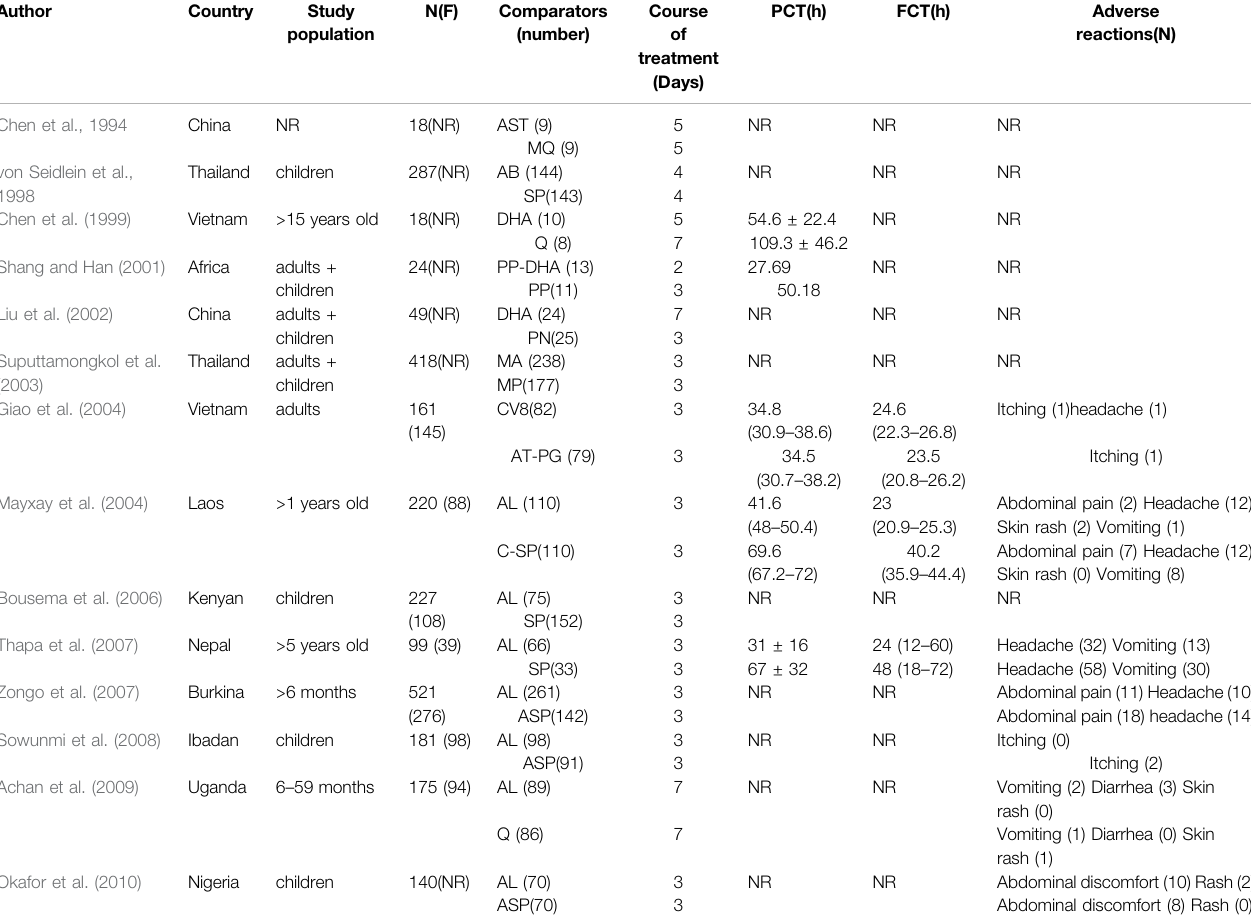
TABLE 1 | Characteristics of the included